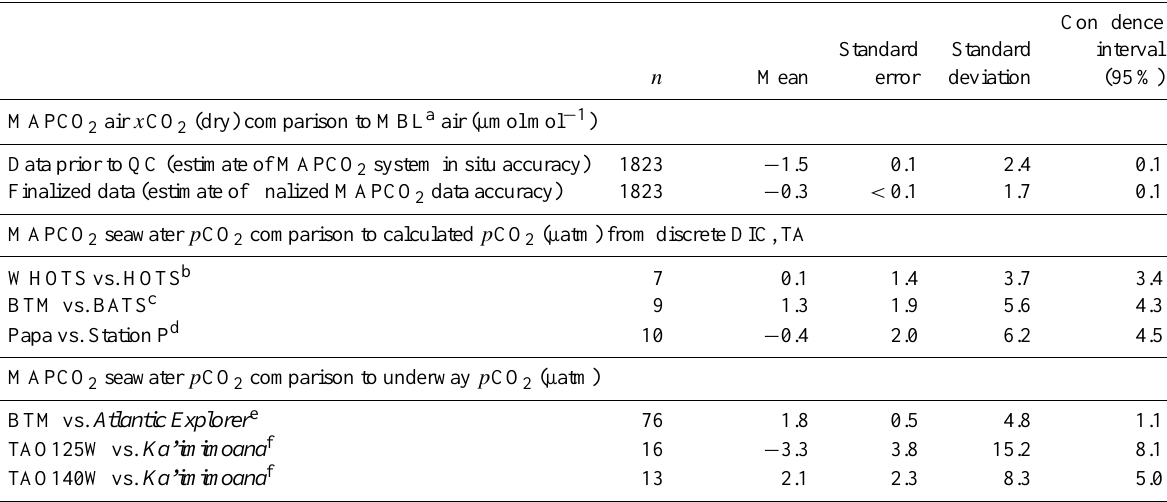
Table 5. Descriptive statistics of 1 (MAPCO 2 measurement – comparison measurement). The MAPCO 2 measurements (both pre- and post-offset if applied during data QC) are compared to biweekly GLOBALVIEW-CO2 MBL values from the latitude nearest to average buoy location, single discrete measurements made within 10km and 1.5h, and averaged underway p CO 2 measurements made within 10km and 10min of the MAPCO 2 system measurement. Standard error is the standard error of the mean, and confidence intervals illustrate that with a 95% probability the actual population mean = sample mean ± confidence